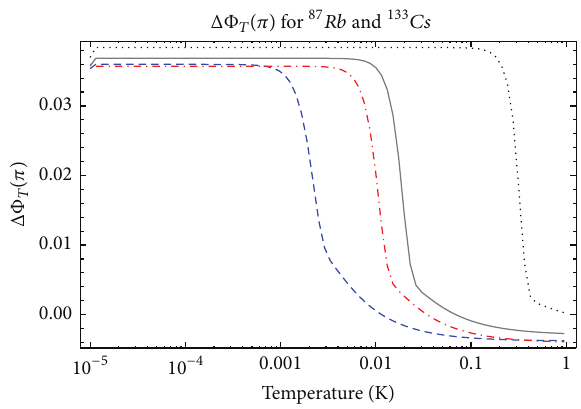
Figure 2: Plots of ΔΦ 𝑇 as function of the temperatures of cold sources 𝑇 𝑐 , for the splitting between the hyperfine energy levels and 133 𝐶𝑠 , 6 2 𝑃 𝐹 = 4 → 𝑇 ℎ values: (blue) dashed line: 3 / 2 line, splitting for = 251 . 09 MHz, 𝛾 = 32 . 889 MHz [54]) and 𝐹 = 5 transition (𝜔 0 0 = 10 − 2 K; (red) dot-dashed line: 87 𝑅𝑏 , 5 2 𝑃 𝑇 ℎ 1 / 2 line, splitting for = 814 . 5 MHz, 𝛾 = 36 . 129 MHz 𝐹 = 1 → 𝐹 = 2 transition ( 𝜔 0 0 [53]), and 𝑇 ℎ = 3 × 10 − 2 K; (gray) solid line: 133 𝐶𝑠 , 6 2 𝑃 1 / 2 line, splitting for 𝐹 = 3 → 𝐹 = 4 transition ( 𝜔 0 = 1167 . 68 MHz, 𝛾 0 = 28 . 743 MHz [54]) and 𝑇 ℎ = 6 × 10 − 2 K; (black) dotted line: 133 𝐶𝑠 , 6 2 𝑆 1 / 2 line, splitting for 𝐹 = 3 → 𝐹 = 4 transition ( 𝜔 0 = 9 . 192 GHz, = 28 . 743 MHz [54]) and 𝑇 = 1 K. The time considered is 𝛾 0 ℎ 𝑡 ≃ 1 / 4 𝜔 0 s.